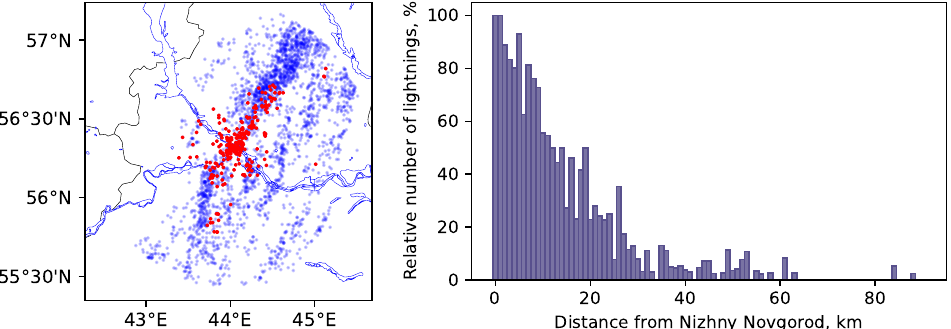
Figure 2. Illustration of the efficiency of lightning detection using field mill «Boltek EFM-100» on the example of lightning activity on 13–14 July 2020 in the Nizhny Novgorod region. Left panel: all lightning events detected by the WWLLN within a radius of 100 km from the observation point are shown by the blue color; the discharges that coincided in time with the discharges determined according to the EFM measurements are marked by the red color. Right panel: the ratio of the number of lightning events registered by both the EFM and WWLLN to the number of all lightning events detected by the